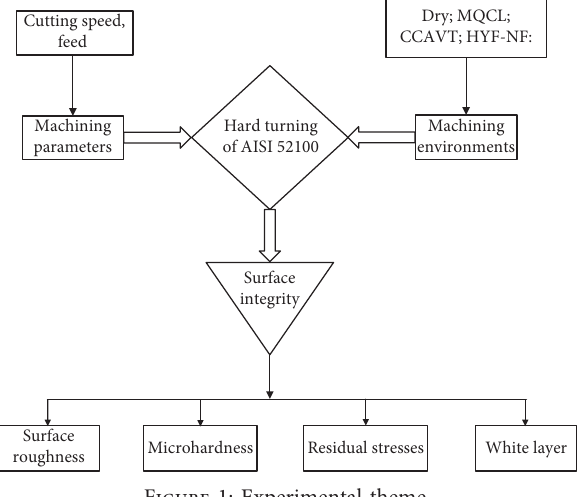
Figure 1: Experimental